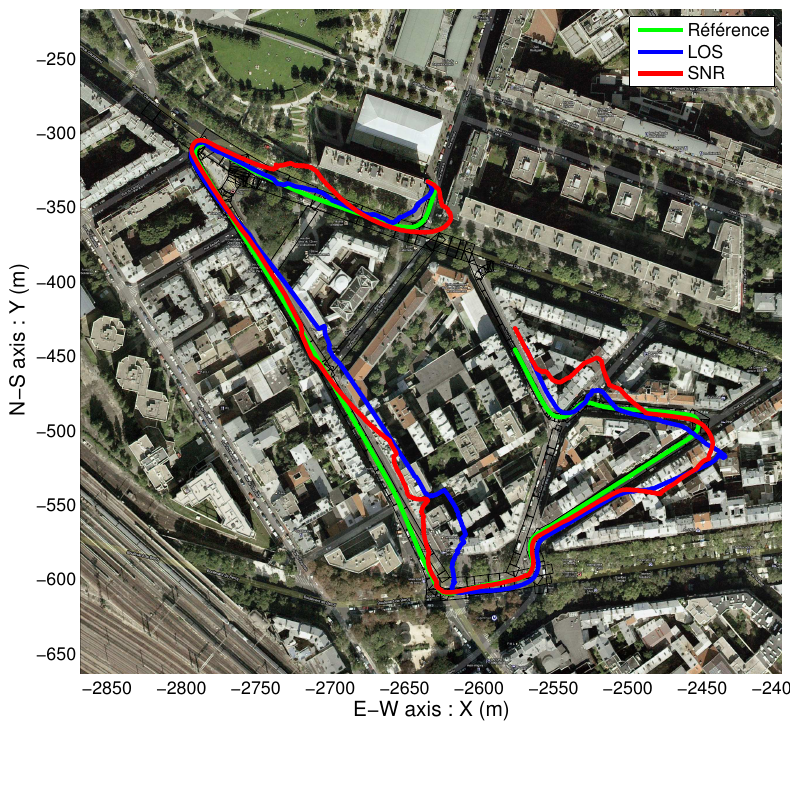
Figure 12. 2D overview of ”free” solutions (without map-aiding) for both strategies.